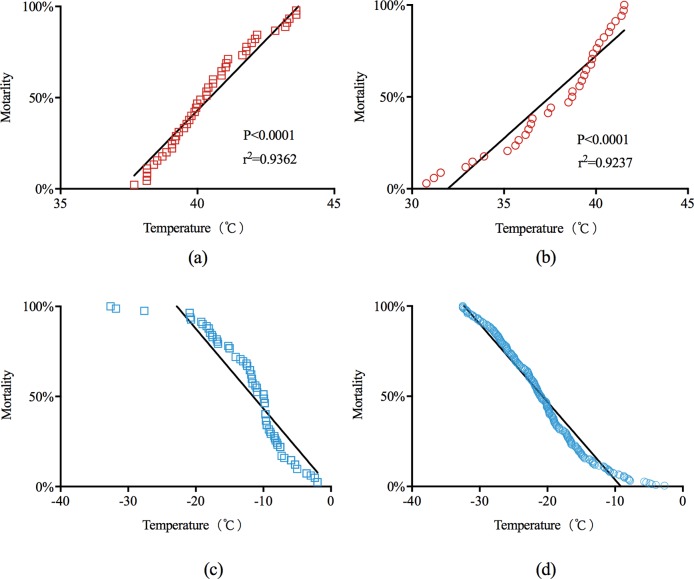
Straight line fitting graph of mortality with temperature rising.Since the experimental observation found that the individual was in a state of death after the experiment, the Y-axis used “mortality”. (a) CTmax of adults (y = 0.1546x - 5.754, F = 631.3, d.f. = 1;43). (b) CTmax of larvae (y = 0.08982x - 2.869, F = 387.3, d.f. = 1;32). (c) SCP of adults (y = -0.04436x - 0.01056, F = 457, d.f. = 1;80). (d) SCP of larvae (y = -0.04319x - 0.3949, F = 5480, d.f. = 1;319).